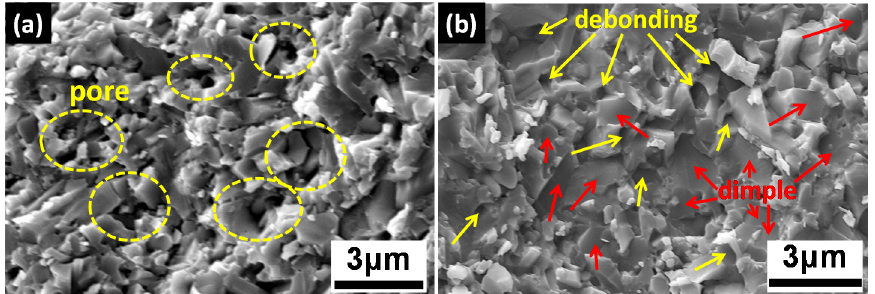
Figure 6. Typical fracture surfaces of Si 3 N 4 with ( a ) 7 wt.% (Al 2 O 3 -Y 2 O 3 ), ( b ) 10 vol.% Ti 3 SiC